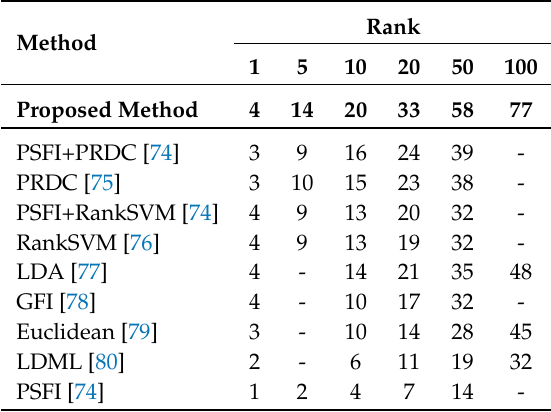
Table 6. Comparison of CMC rates (in [%]) of Re-Id methods on PRID2011 dataset, ‘-’ indicates no result was reported.